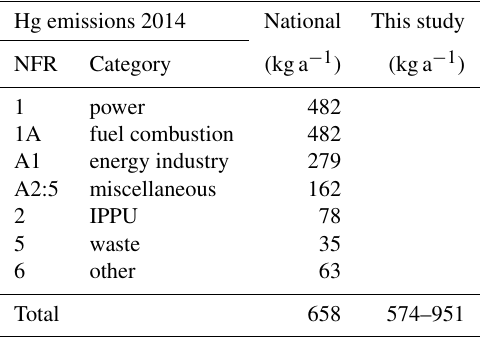
Table 2. Swiss national inventory for mercury emissions in 2014 as submitted under the UNECE Convention on Long-Range Trans- boundary Air Pollution. (NFR: nomenclature for reporting emission categories, IPPU: industrial processes and product